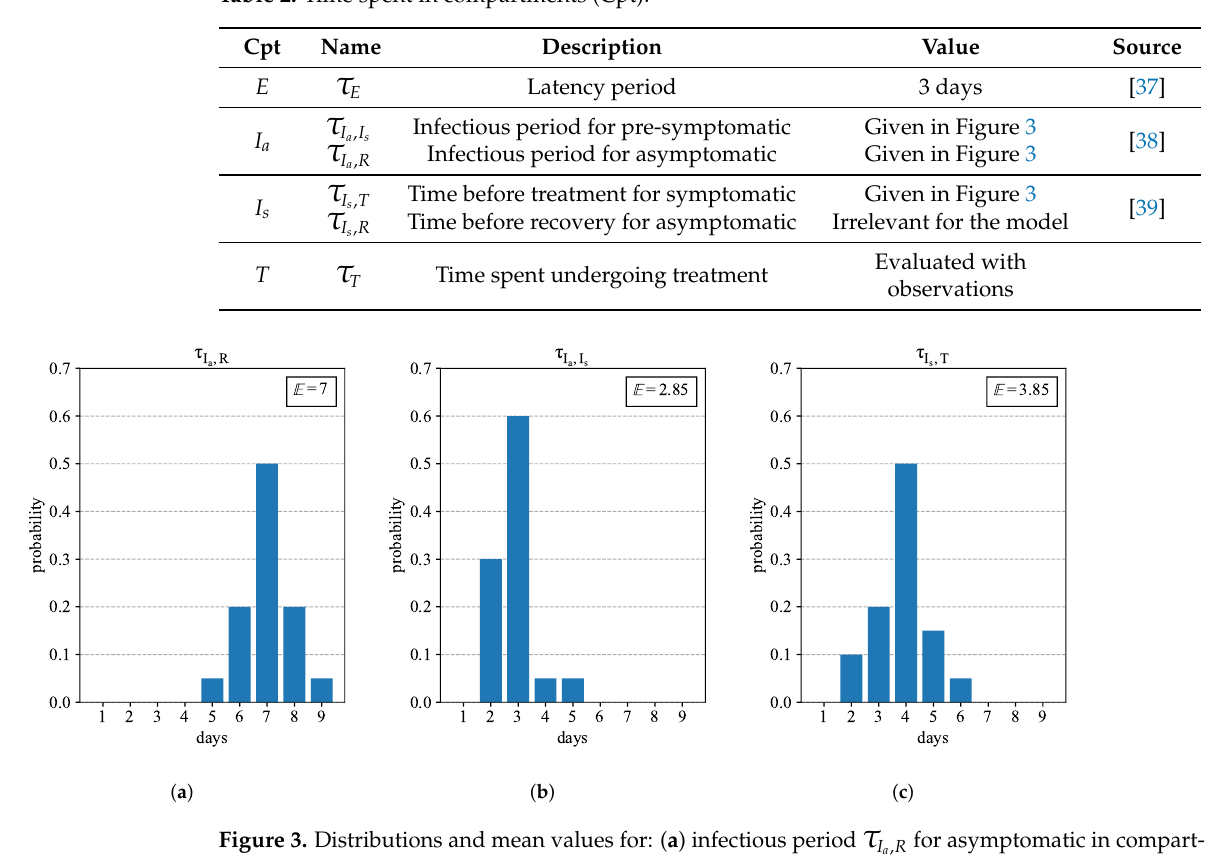
for pre-symptomatic in compartment I a ; and ( c ) time τ I a , I s